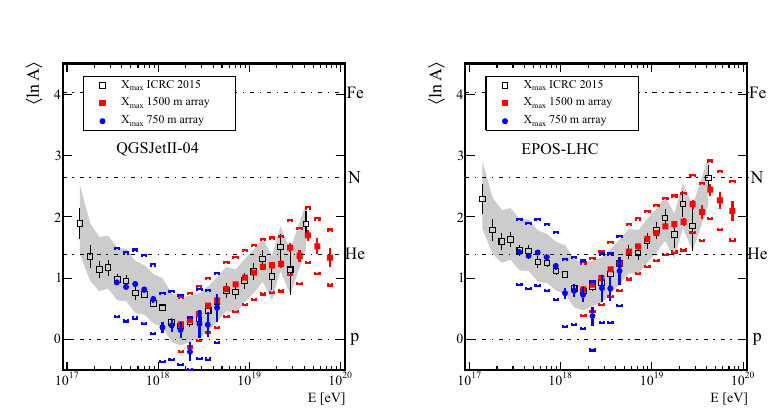
0.00.20.40.60.81.0 680 700 720 740 760 780 800 820 (cid:2) X (cid:3) / gcm − 2 max Figure 3. (Left) Average logarithmic muon content as a function of the average shower depth (cid:2) X max (cid:3) . Model predictions are obtained from showers simulated for θ = 67 ◦ for proton and iron showers, and interpolated for helium and nitrogen showers [6]. (Right) Best-fit values of R E and R had . The ellipses and grey boxes show the 1- σ statistical and systematic uncertainty